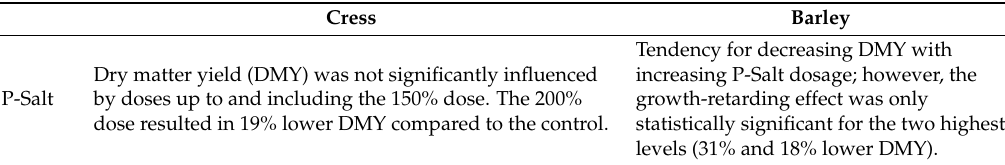
Table 7. Results of crop growth